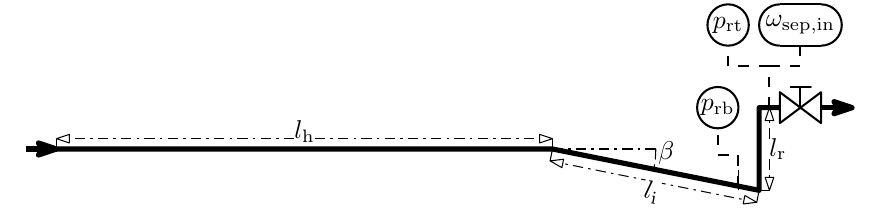
Figure 3. Drawing of the well-pipeline-riser test facility.